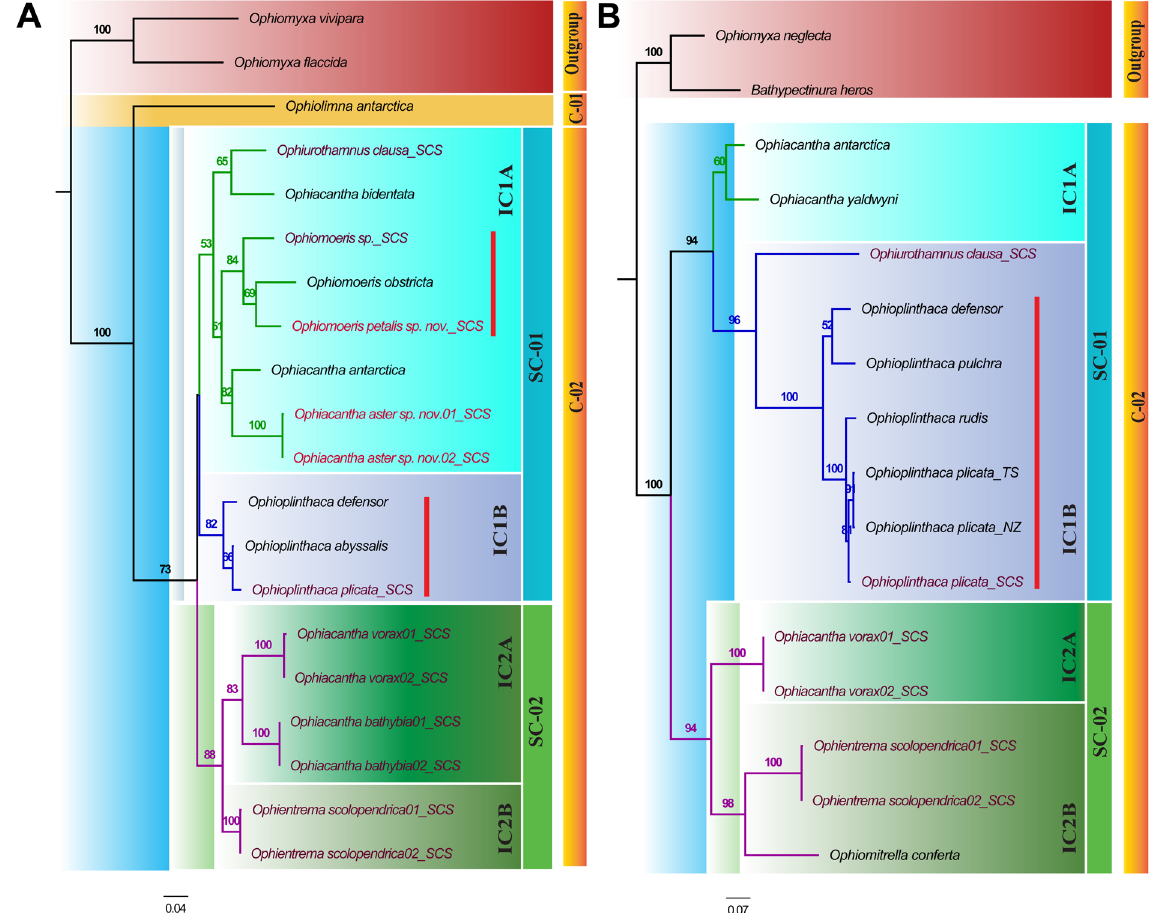
Fig. 47. Family Ophiacanthidae Ljungman, 1867, Maximum likelihood (ML) trees based on partial 16S and COI sequences (bootstrap support values were generated with rapid bootstrapping algorithm for 1000 replicates). A . 16S ML. B . COI ML. Abbreviations: C = Clade; IC = Inter-Clade; NZ = New Zealand; SC = Sub Clade; SCS = South China Sea; TS = Tasman